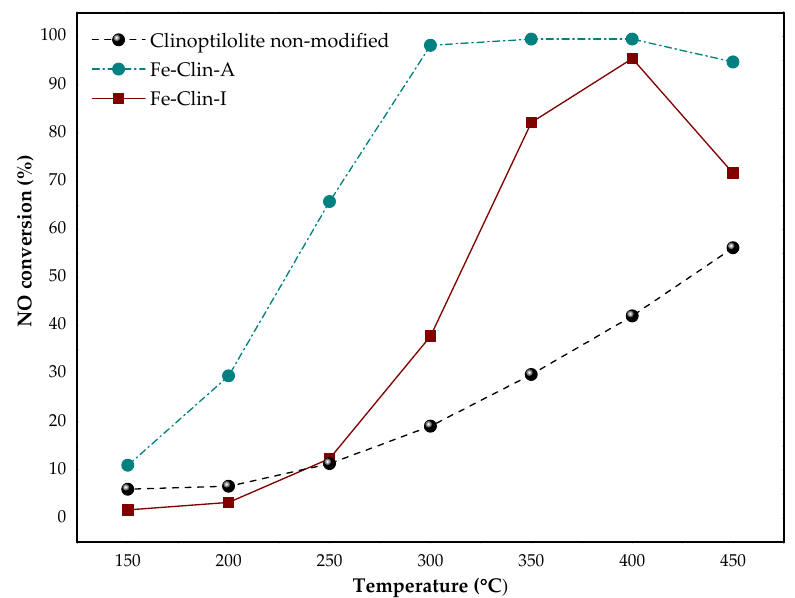
Figure 5. The results of NO conversion during NH 3 -SCR process obtained for non-modified clinoptilolite, Fe-Clin-A, and Fe-Clin-I at gas hourly space velocity (GHSV) = 26,500 h − 1 .